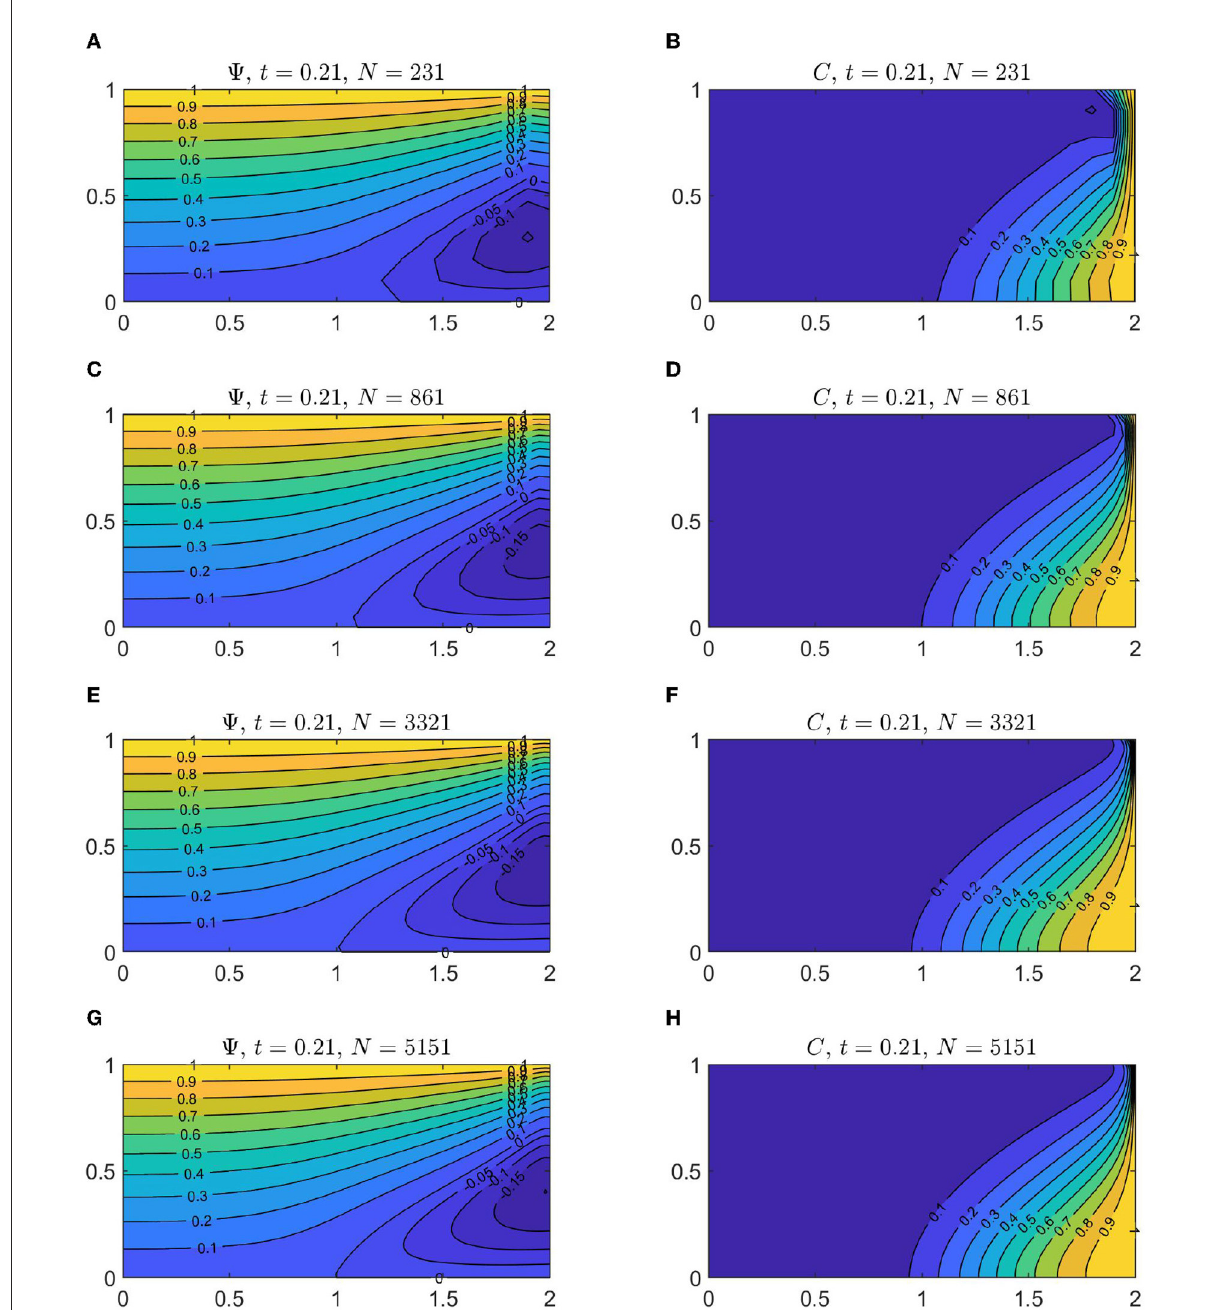
FIGURE9 Steady-state streamlines distribution (Left) and steady-state concentration distribution (Right), for the Henry problem ( a = 0.2637, b = 0.035) using different number of total nodes. (A,B) N = 21 × 11 = 231, (C,D) N = 41 × 21 = 861, (E,F) N = 81 × 41 = 3,321, (G,H) N = 101 × 51 = 5,151.